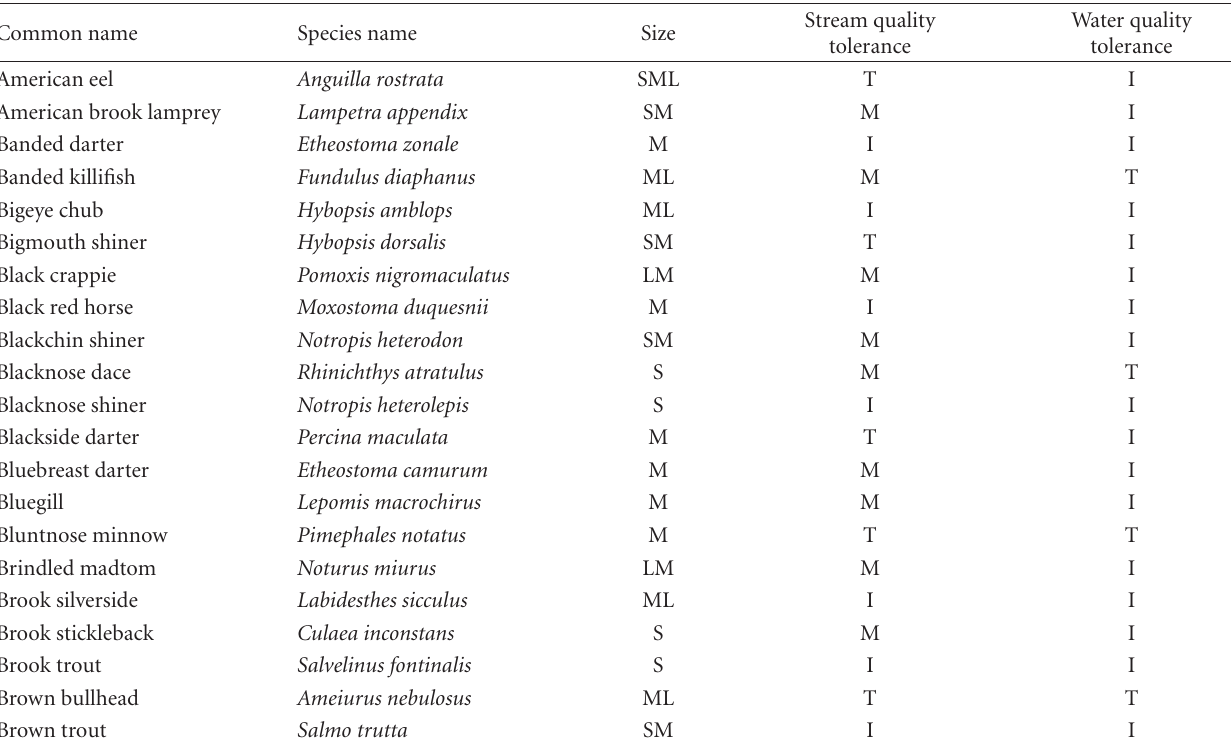
Table 2: Stream size, stream quality, and water quality preferences and tolerances for fish species in the upper Allegheny River basin. Size: S: small, M: midsize, L: large. Stream quality and water quality tolerances: I: intolerant, M: moderately tolerant, T: